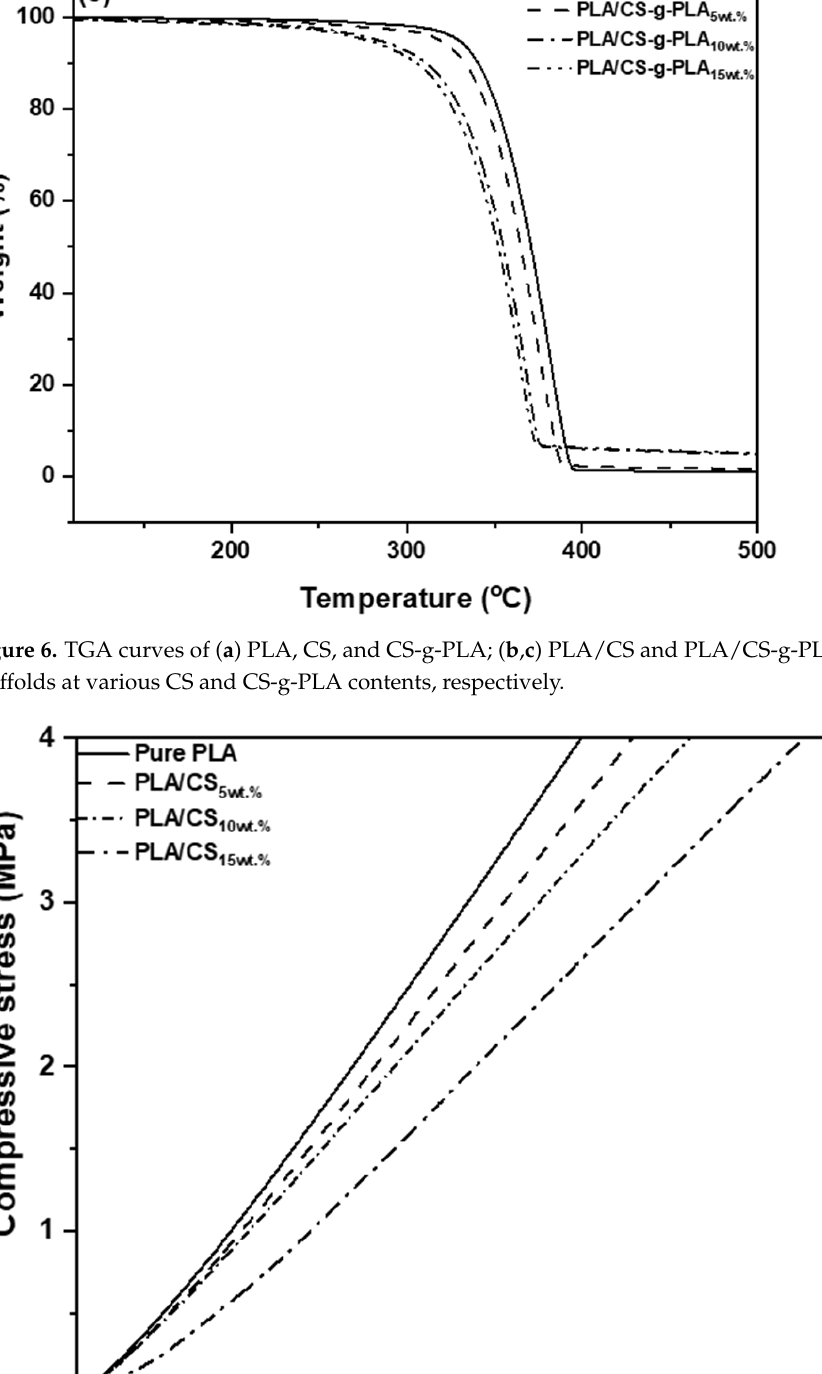
Figure 6. TGA curves of ( a ) PLA, CS, and CS-g-PLA; ( b , c ) PLA/CS and PLA/CS-g-PLA composite scaffolds at various CS and CS-g-PLA contents, respectively.